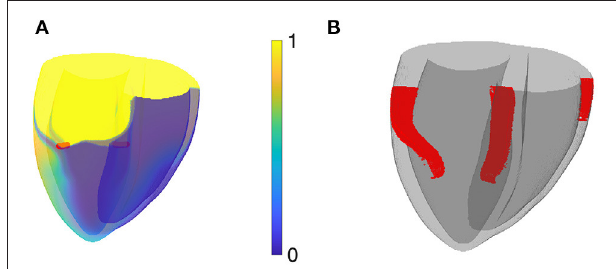
FIGURE 12 | Numerical simulation of rotors in the BOCF model in a biventricular human geometry. (A) Snapshot colored according to normalized